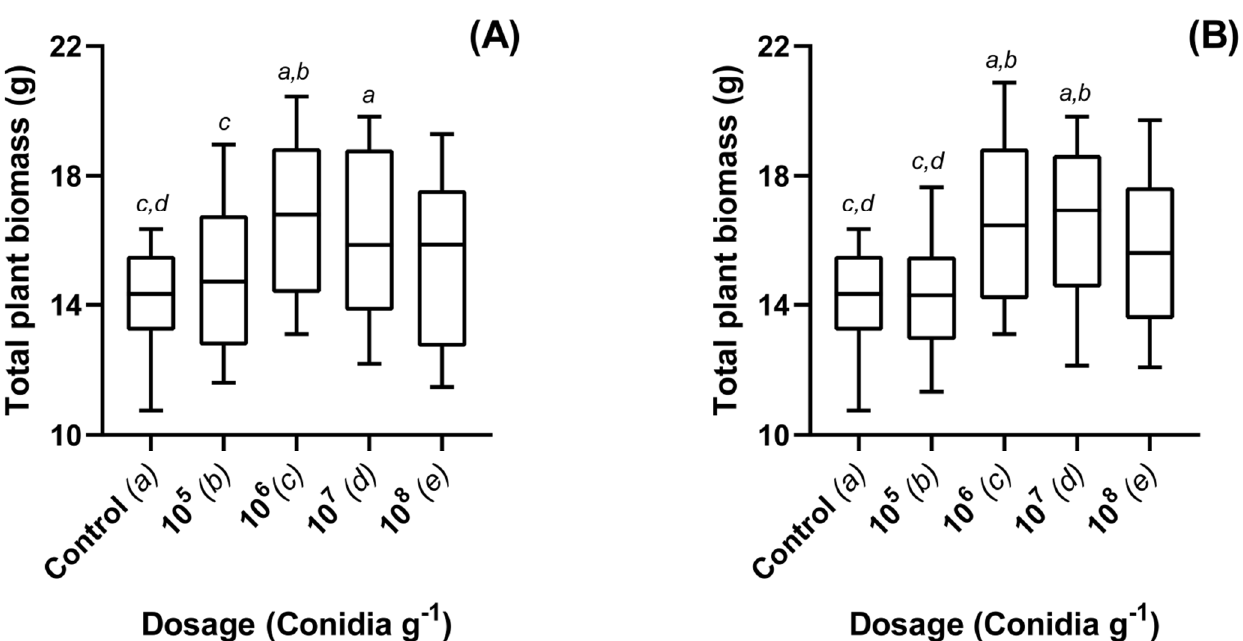
Figure 1. Total plant biomass (g) of Oilseed rape plants treated with different concentrations of Metarhizium brunneum strains: ( A ) V275 and ( B ) 4556. Whole plant fresh weights recorded for OSR exposed to different concentrations V275 or ARSEF 4556 as conidia g − 1 of compost. Plants were grown in a glasshouse maintained at 25 ± 2 ◦ C for a total of six weeks. Controls were exposed to compost media without additional treatment. Figure display’s minimum, 1st quartile, median, 3rd quartile and maximum measurements within the treatment group. Significant results denoted between treatments using letters ( a – e ) above each boxplot; where denotation letters are absent, no significant differences were detected between treatments.